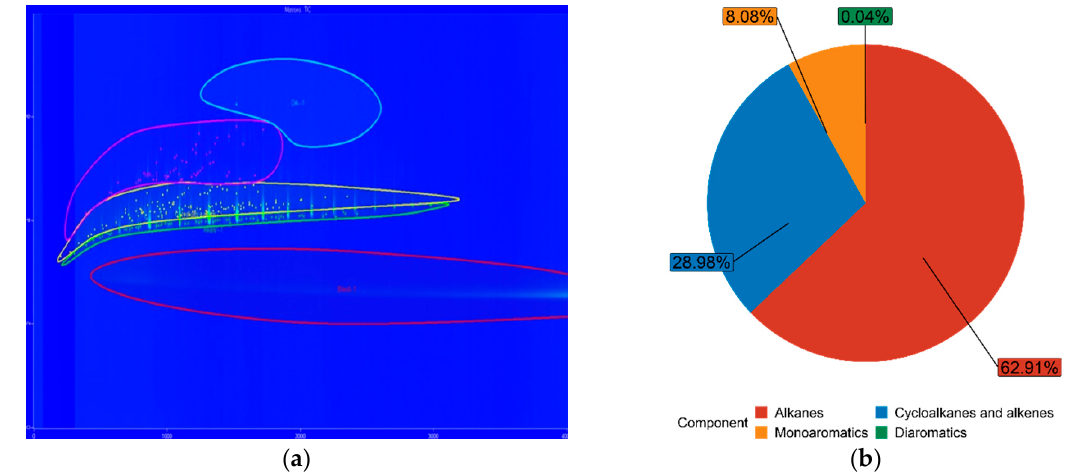
Figure 12. ( a ) Output of GC × GC-TOFMS for 7% FT − diesel; ( b ) hydrocarbon composition of 7% FT-diesel.